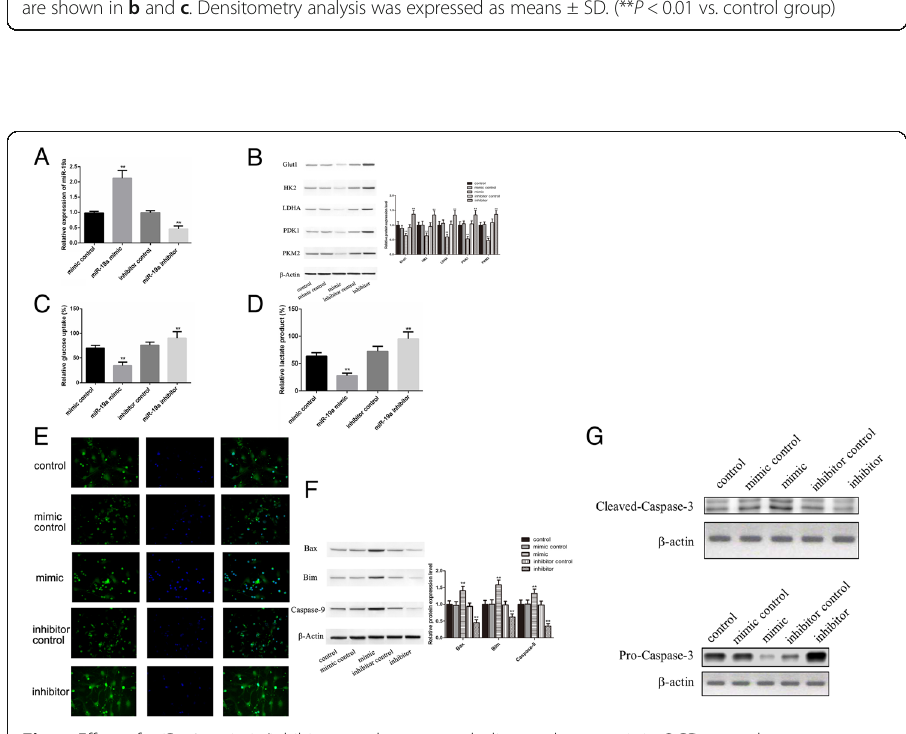
Fig. 4 Effect of miR-19a mimic/inhibitor on glucose metabolism and apoptosis in OGD-treated neurons. a , Successful transfection of miR-19a-3p mimic/inhibitor was verified by qRT-PCR. B-F, The effects of miR-19a-3p on expression of glycolytic enzymes ( b ), glucose uptake, ( c ) lactate production ( d ), and apoptosis ( e - g ) were assayed as described in Figs. 2 and 3. All data were expressed as means ± SD. (** P <0.01 vs. control